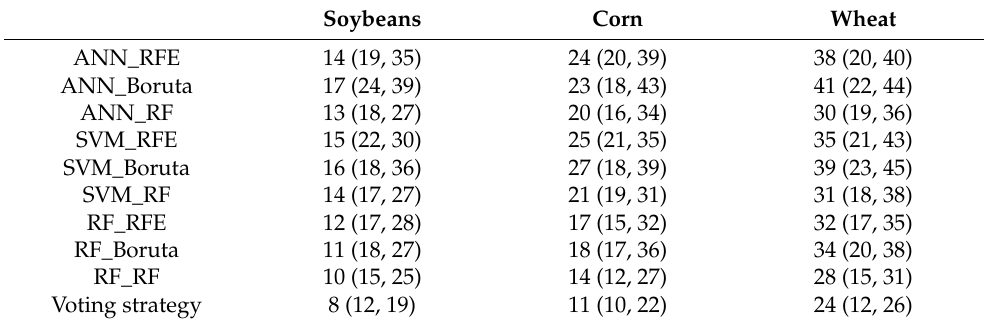
Table 2. Mean of commission and omission errors for each land crop/cover classes at test site 1 (2, 3). Soybeans Corn Wheat Soybeans Corn